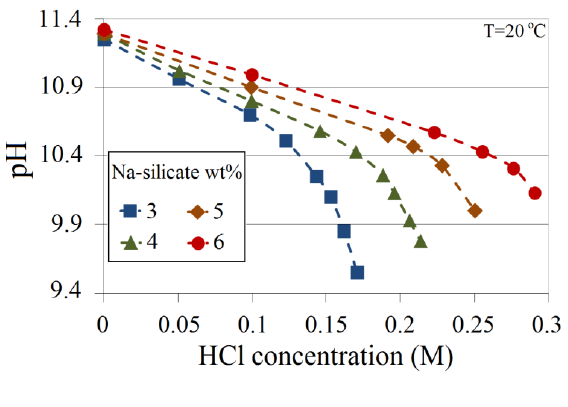
Figure 3. Corresponding pH for 3 wt%, 4 wt%, 5 wt% and 6 wt% Na-silicate solutions as a function of HCl